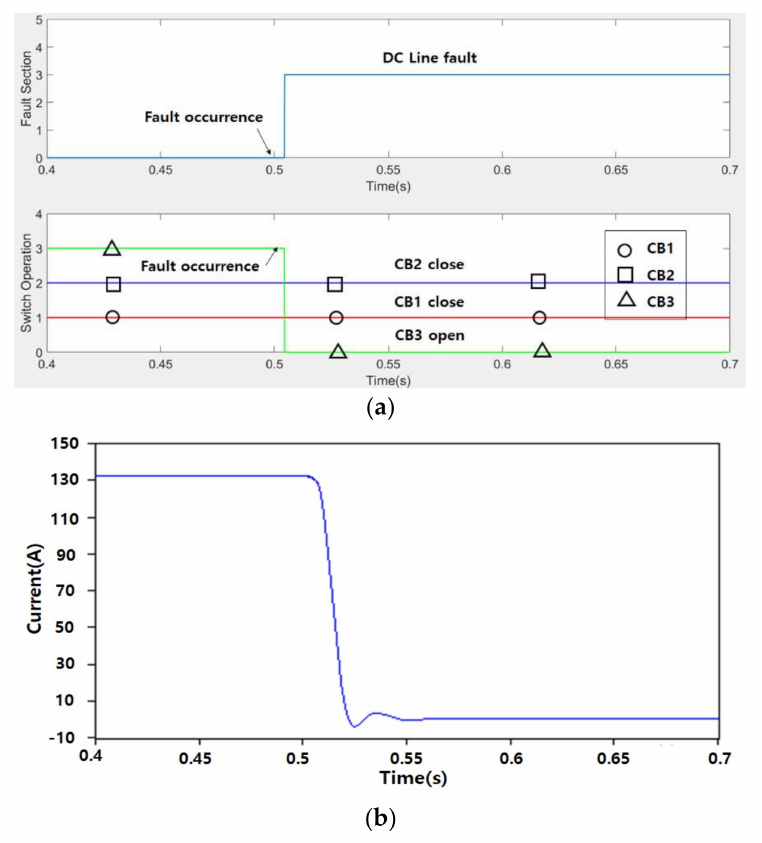
Figure 16. Simulation results of Case 4: ( a ) Fault section and CB operation and ( b ) Load